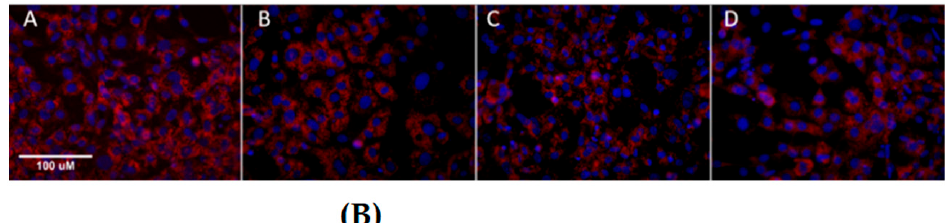
Figure 2. Effects of metformin and simvastatin on lipid accumulation in 3T3-L1 cells. ( A ) The integrated density of quantified Oil Red O staining relative to the cell count. A = differentiated cells, B = cells treated with metformin 200 µ M, C = cells treated with metformin 2 mM, D = C = cells treated with metformin 4 mM, E = cells treated with simvastatin 100 nM, F = cells treated with simvastatin 1 µ M, G = cells treated with simvastatin 2 µ M, H = cells treated with the combination of metformin 200 µ M and simvastatin 100 nM, I = cells treated with the combination of metformin 2 mM and simvastatin 1 µ M, J = cells treated with the combination of metformin 4 mM and simvastatin 2 µ M. The data are shown as the means ± SD (standard deviation) from three independent experiments. Data represents a percentage relative to differentiated cells as the control group (One-way ANOVA F(9,27) = 1.04, p = 0.4474 with Tukey HSD post hoc test); ( B ) representative microscopic images presenting lipid droplets formation visualized by Oil Red O staining, captured on the Axioskop 2 MOT micro- scope, 400 × , scale 100 µ M. Blue = DAPI, cell nuclei; red = Oil Red O, lipid droplets. A = differentiated cells, B = cells treated with the combination of metformin 200 µ M and simvastatin 100 nM, C = cells treated with the combination of metformin 2 mM and simvastatin 1 µ M, D = cells treated with the combination of metformin 4 mM and simvastatin 2 µ M.